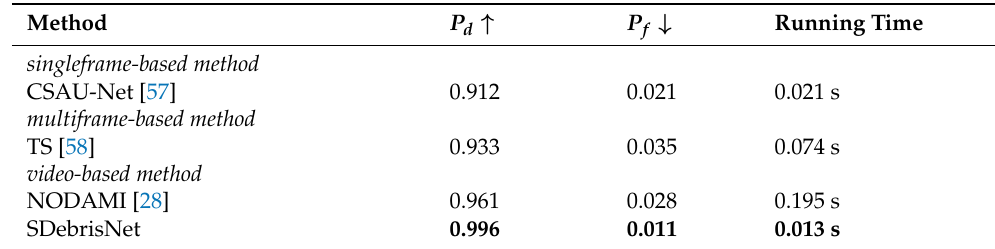
Table 4. Detection results of different space debris detection methods on the SDD dataset.